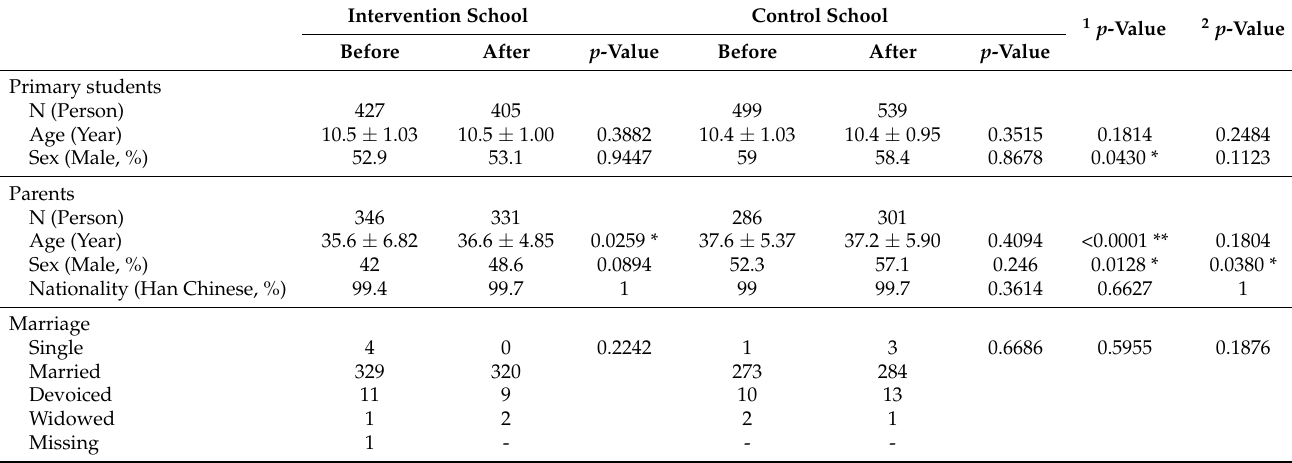
Table 1. General information of the investigated primary students and parents in the intervention and control schools before and after